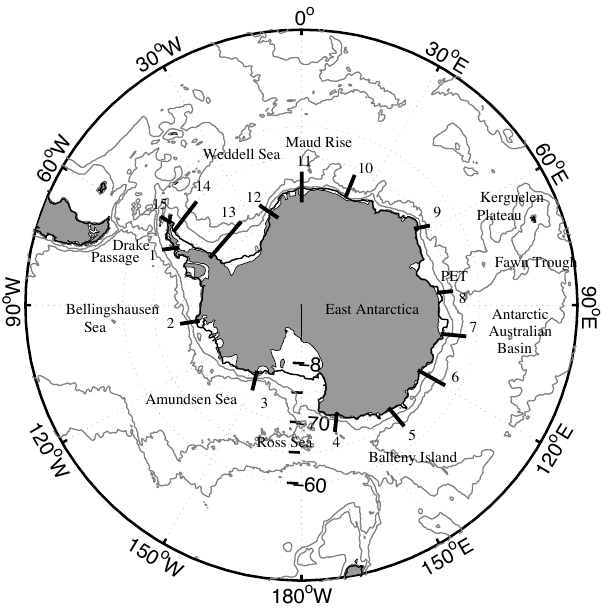
Fig. 1. Sections that are analyzed in the following figures (Figs. 11, 12 and 13). The grey lines correspond to bathymetry (1000m and 3500m). The effective offshore limit for the plots in all the sections and all the simulations is the 3500m bathymetry